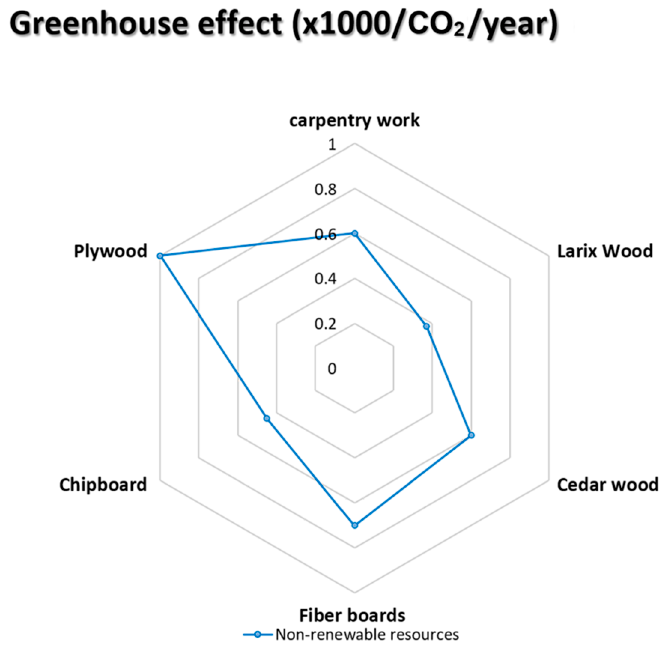
Figure 7. The impact of the greenhouse effect on the selective façade of wooden material [68–72].